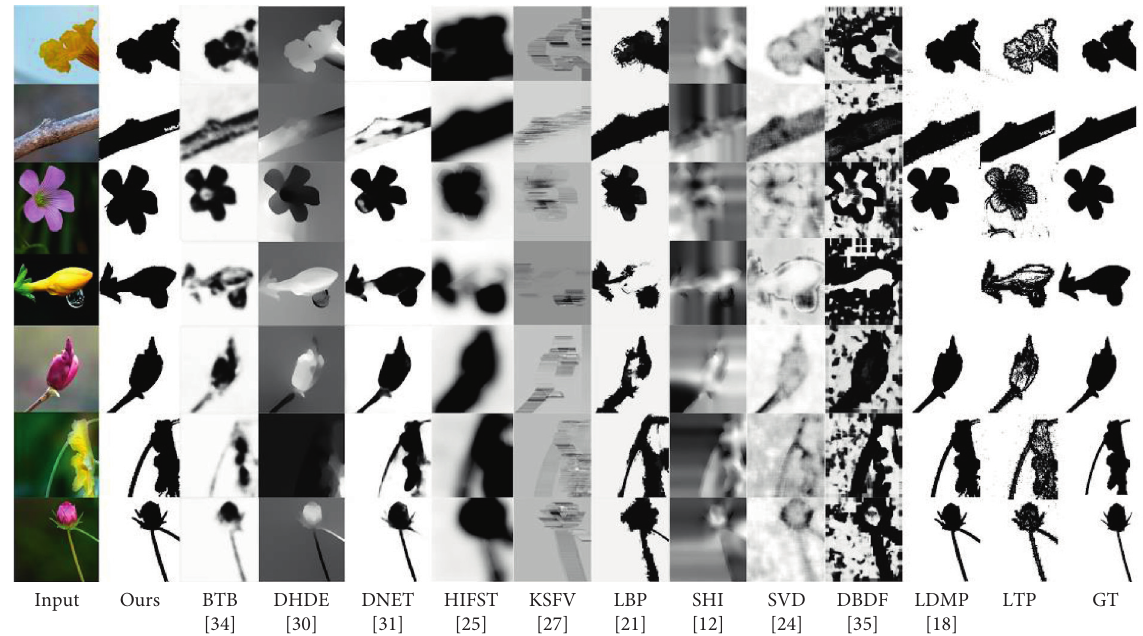
Figure 6: Visual comparison of the proposed method against comparative methods on the DUT dataset.